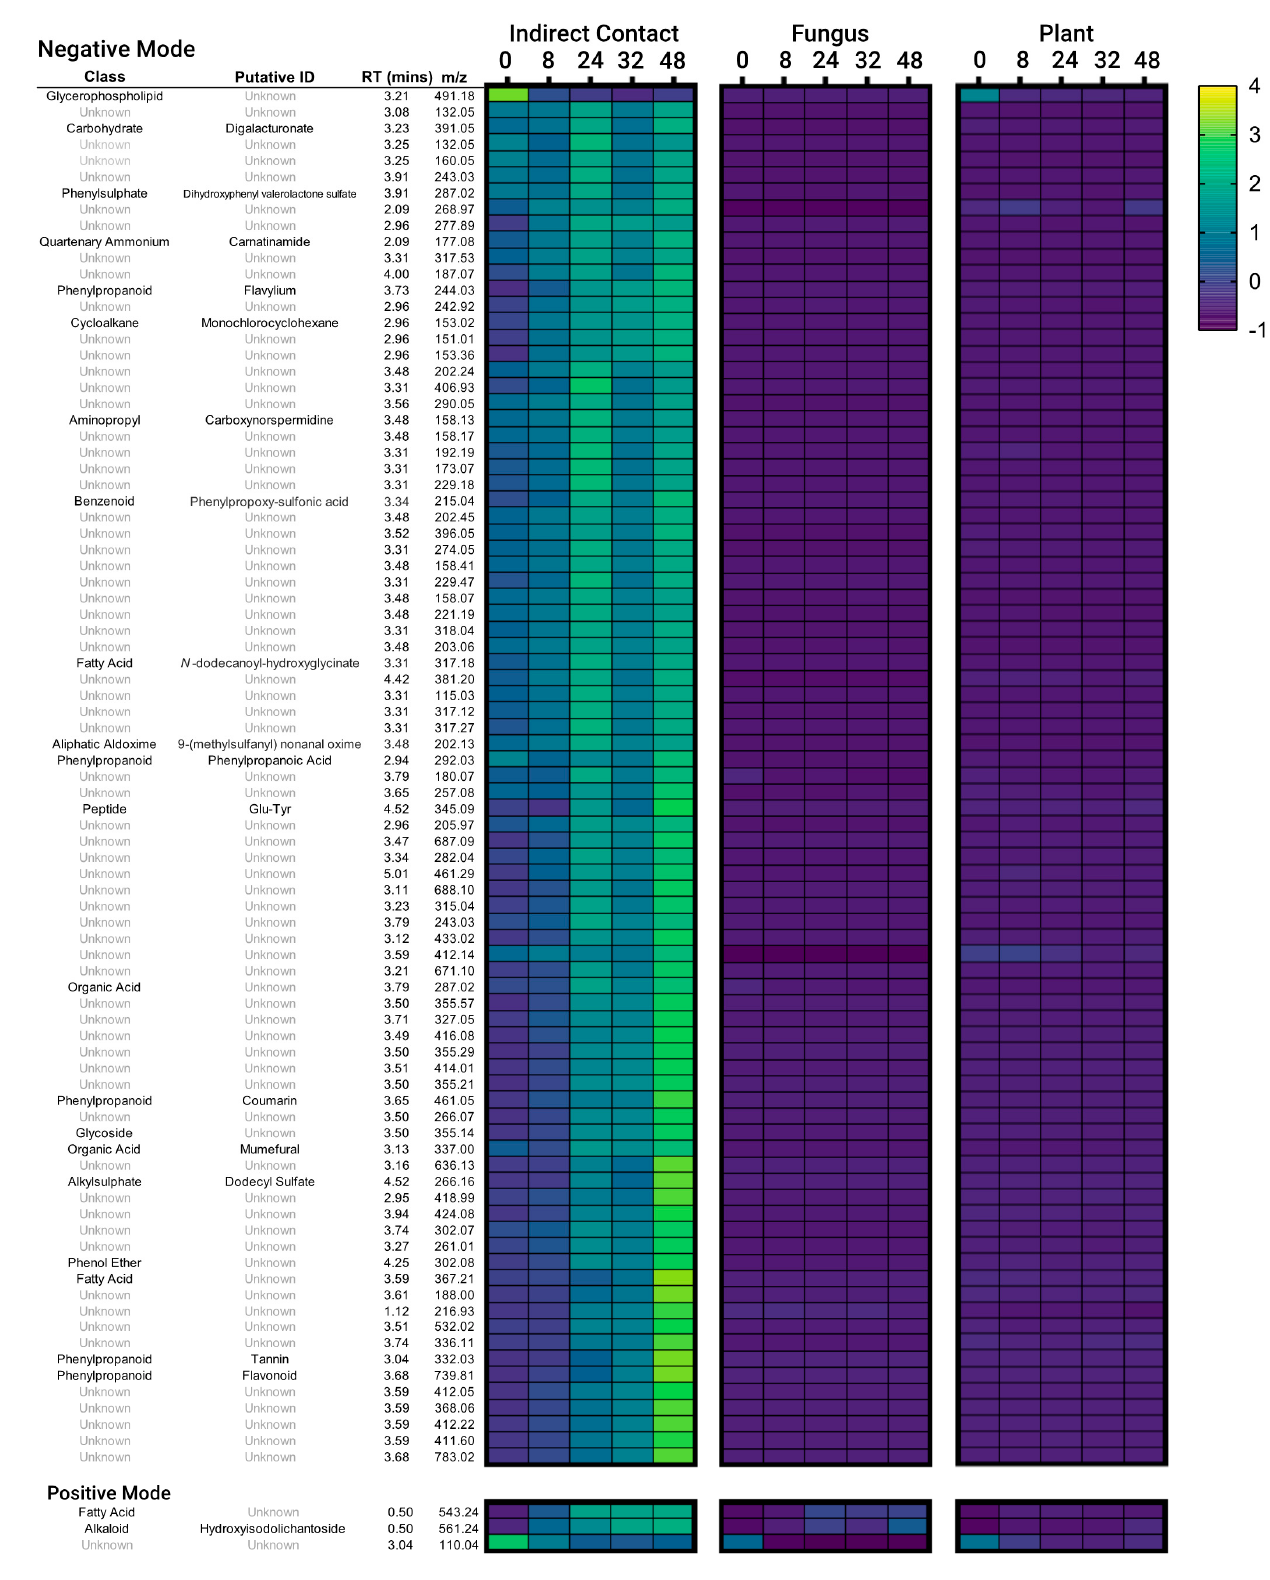
Figure 4. Abundance Z-scores for features identified as significantly elevated in Indirect Contact treatments at 48-h. Z-scores are scaled for each individual feature across all treatments (Indirect Contact, Fungus, Plant) and timepoints (0–48 h).